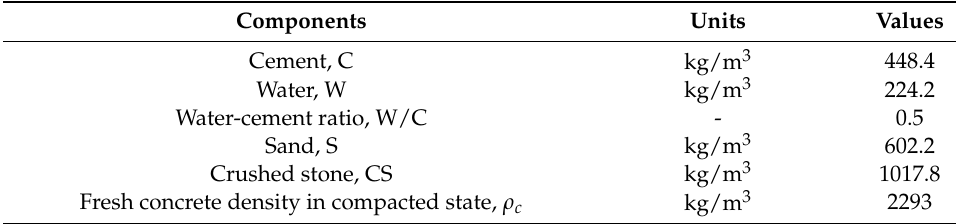
Table 2. Concrete mixture